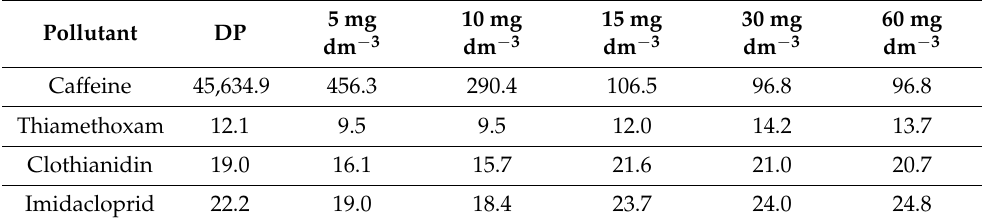
Table 2. Values of the electrical energy per order (EEO, kWh m − 3 order − 1 ) for the degradation of the target pollutants using direct and indirect photolysis. DP: Direct